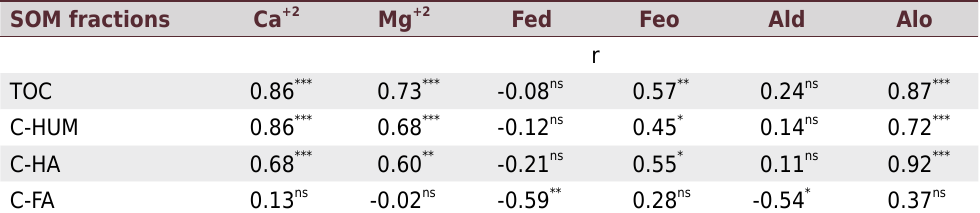
Table 5. Coefficient of determination (r) between fractions of the soil organic matter and soil parameters of Archaeological Dark Earth and Mulatto Earth in western Amazonia, Brazil SOM fractions Ca +2 Mg +2 Fed Feo Ald Alo TOC